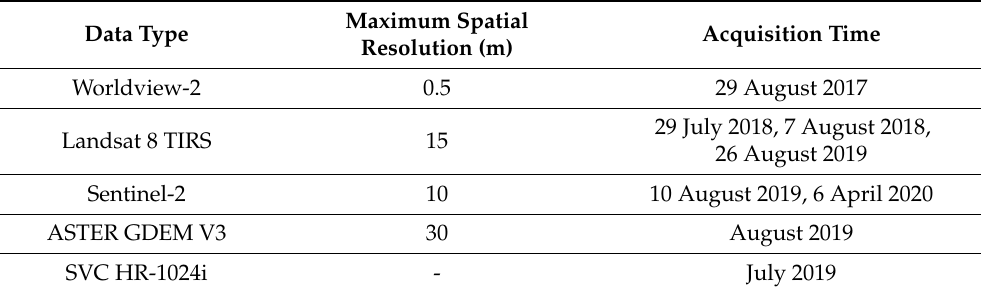
Table 1. List of data